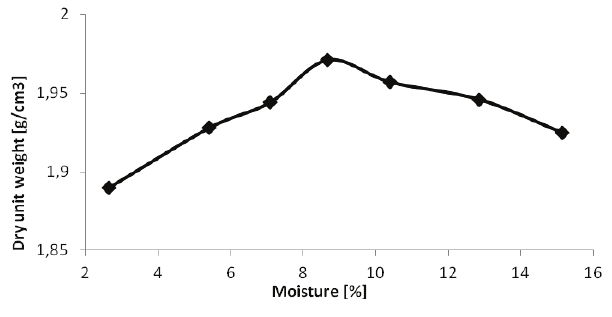
Fig. 2. The proctor test results